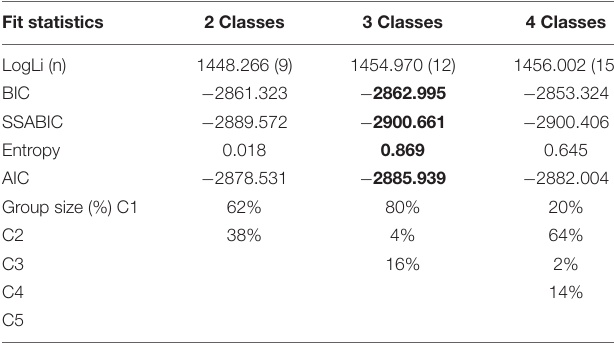
TABLE 2 | Model selection criteria of the Growth Mixture Model (GMM)